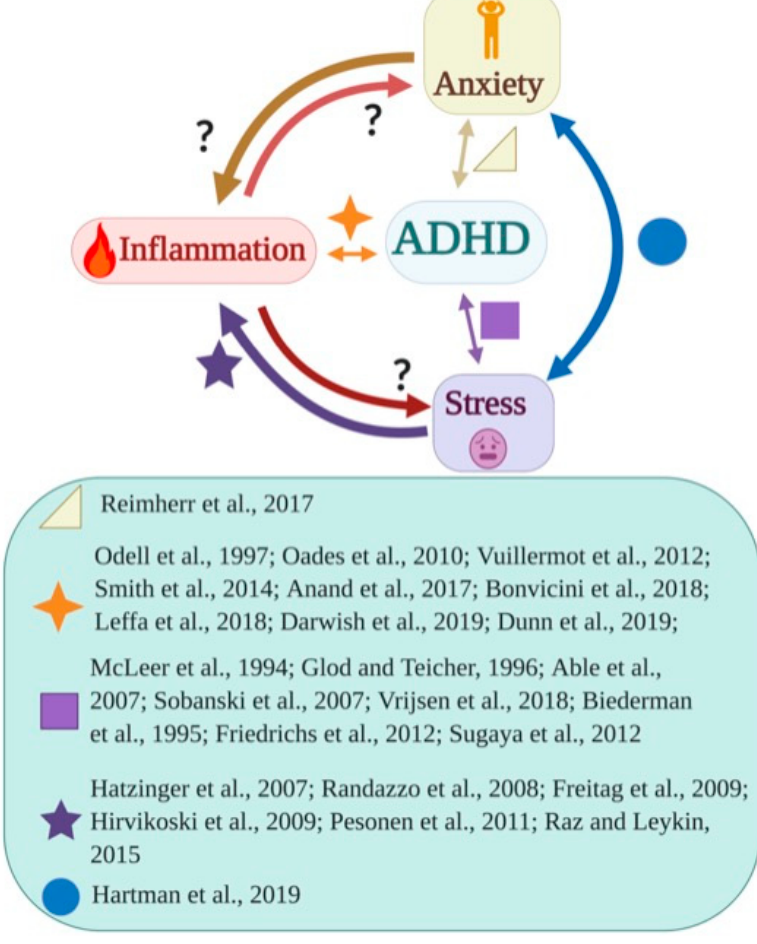
Figure 1. Links between inflammation, stress, and anxiety in attention-deficit/hyperactivity disorder (ADHD). The diagram depicts hypothetical relationships (indicated by arrows) between inflamma- tion, stress, and anxiety in patients with attention-deficit/hyperactivity disorder (ADHD). Arrows connect couples of variables specifying the putative direction of the association between them in ADHD patients. Shapes close to a certain color-matched arrow are associated with main papers that support a link between the two specific variables connected by that arrow. Question marks indicate missing or insufficient evidence for a certain link, based on the reviewed articles. Figure 1 was pre- pared with BioRender.com (2021).